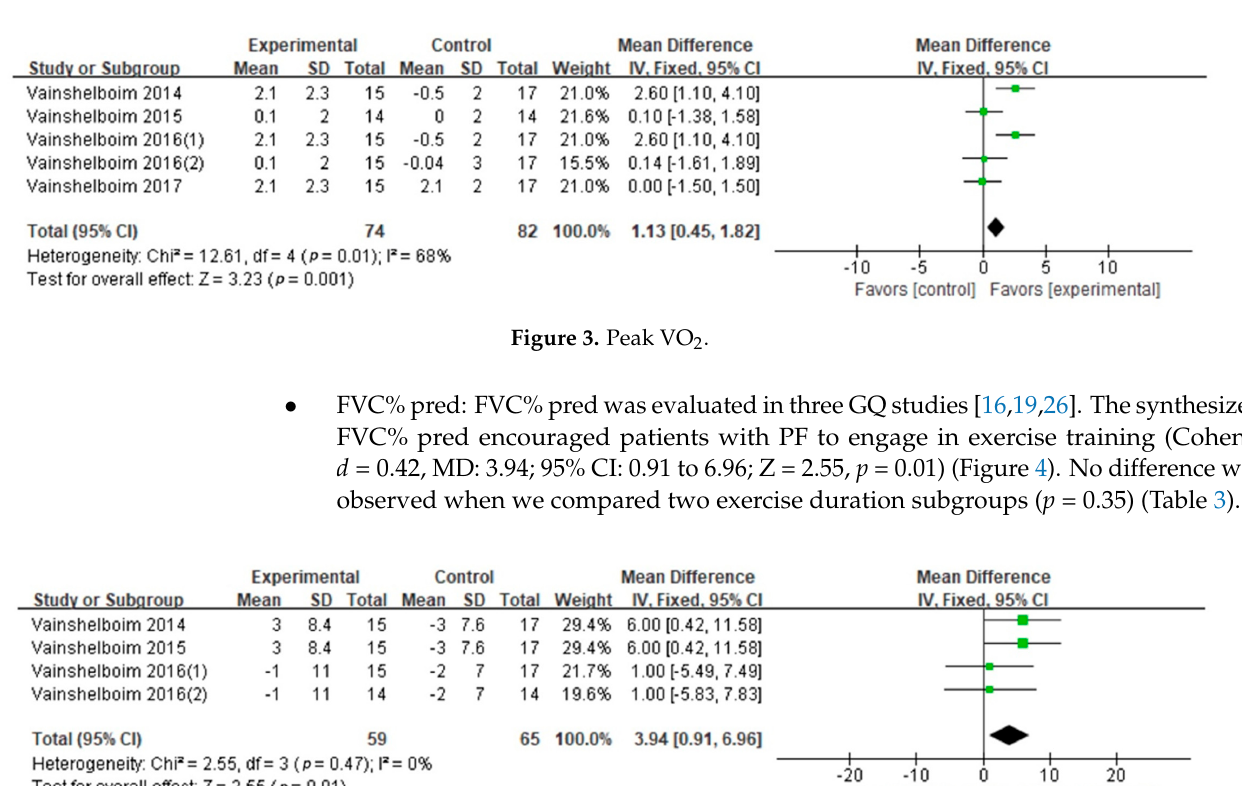
Figure 4. FVC% pred.